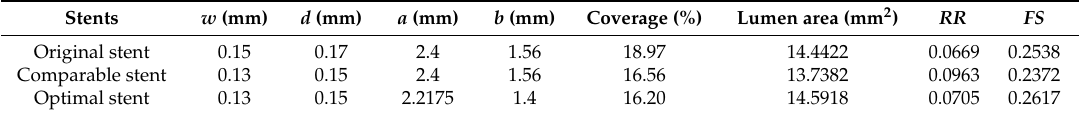
Table 1. Optimization result of stent structure compared to the original stent and comparable stent. Stents w (mm) d (mm) a (mm) b (mm) Coverage (%) Lumen area (mm 2 ) Original